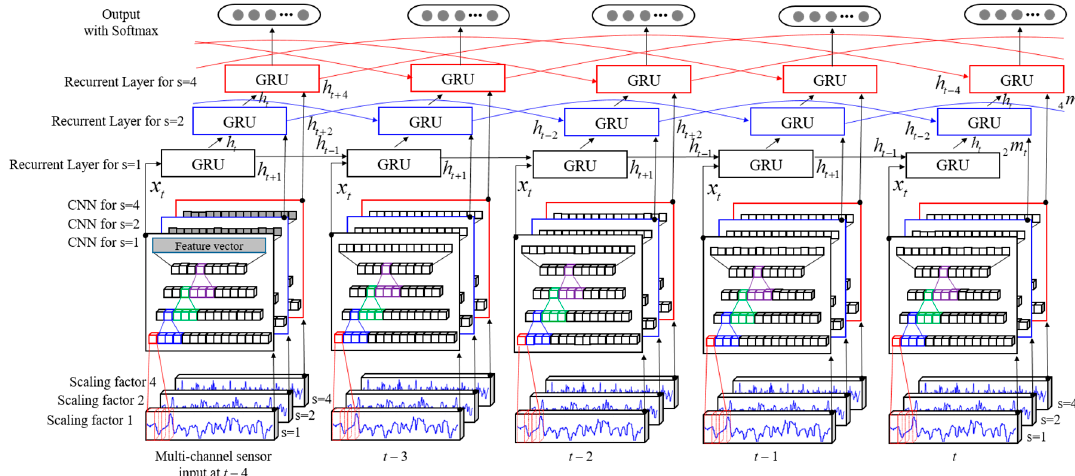
Figure 5. Our proposed hybrid multiscale convolutional and recurrent neural network model to train and estimate the moving speed for segmented and multiscaled sensory signal. The transformed signals with different timescales are fed into a corresponding CNN to extract the feature vector, and then, each feature vector is fed into the corresponding GRU cell as an additional input, s m t . Only the feature vector x t ( s = 1) is fed into the first GRU layer of the stacked RNNs as the input, and h t is used for the input of the upper GRU layer. The recurrent activation at each GRU layer is determined by the scaling factor of the additional input s m t . Finally, the probability distribution for the target moving velocity is computed by Softmax.